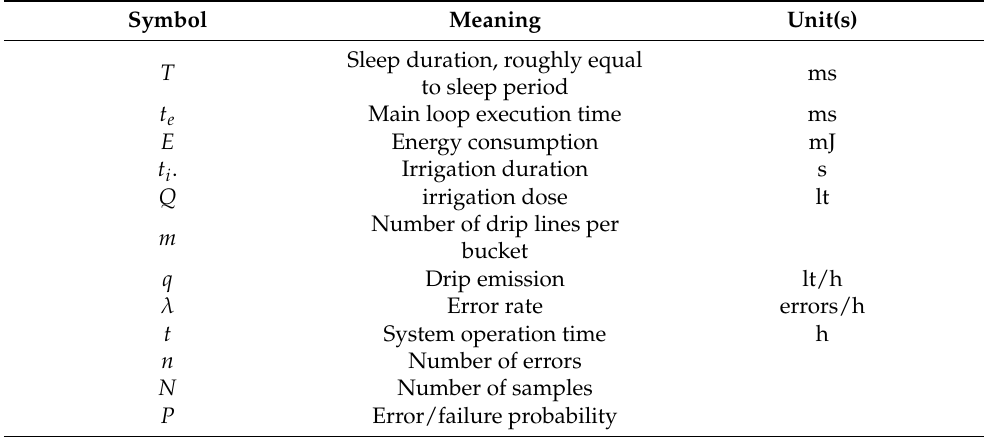
Table A1. Mathematical symbols